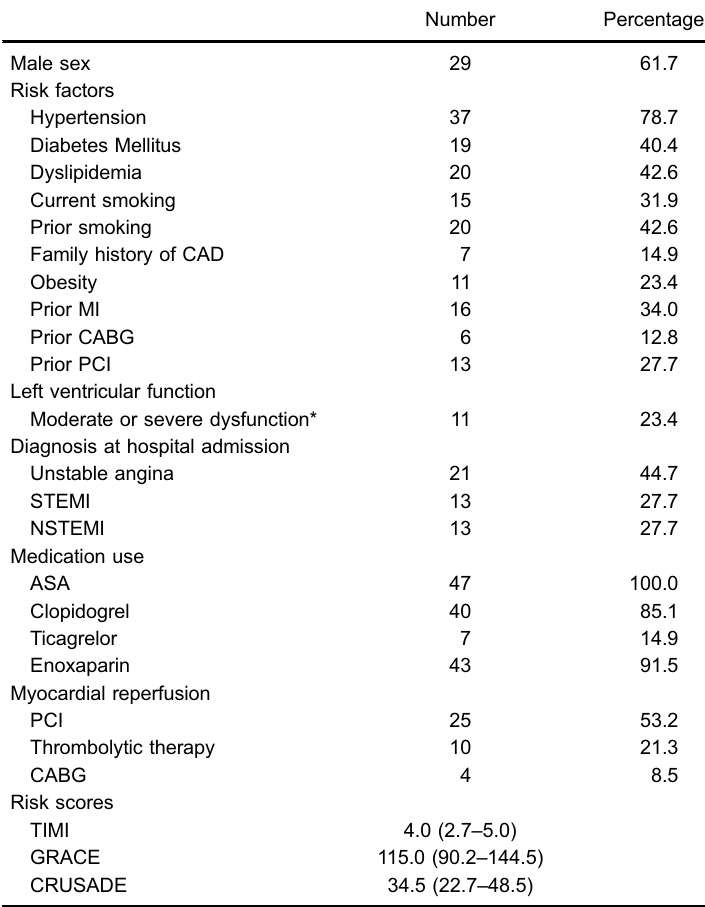
Table 1. Clinical characteristics of patients (n=47).